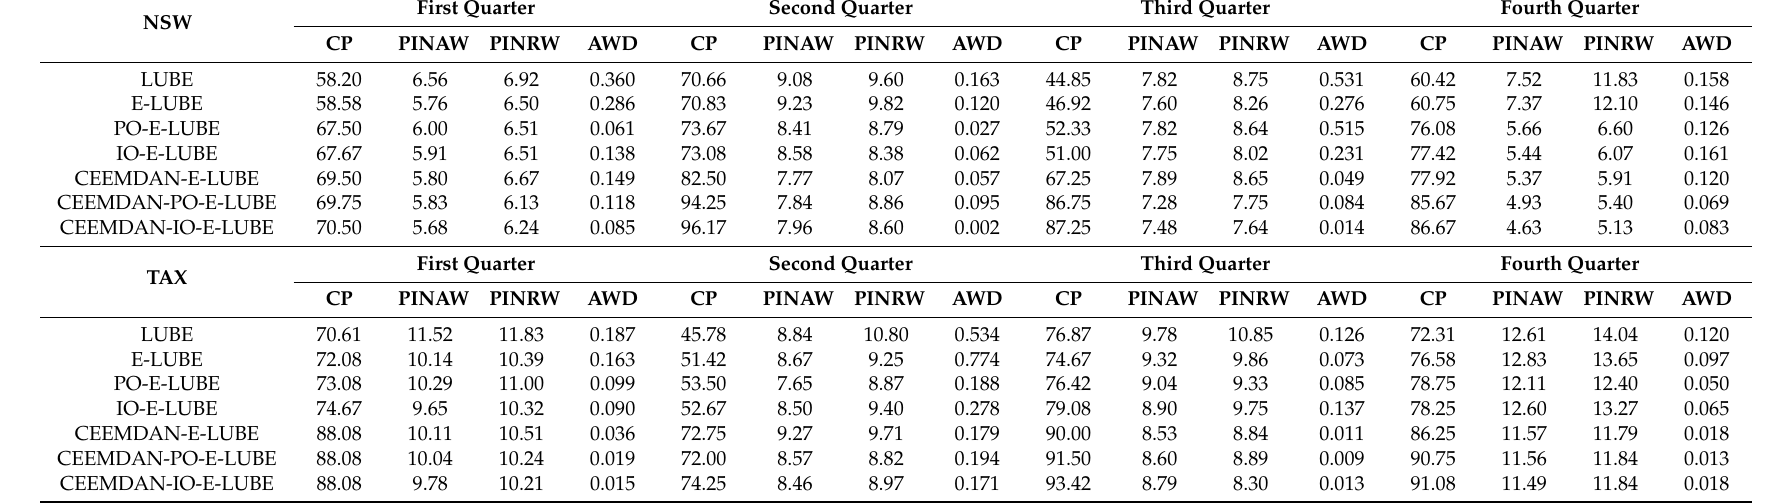
Table 4. Results of different models with α = 0.025 for sample in NSW and